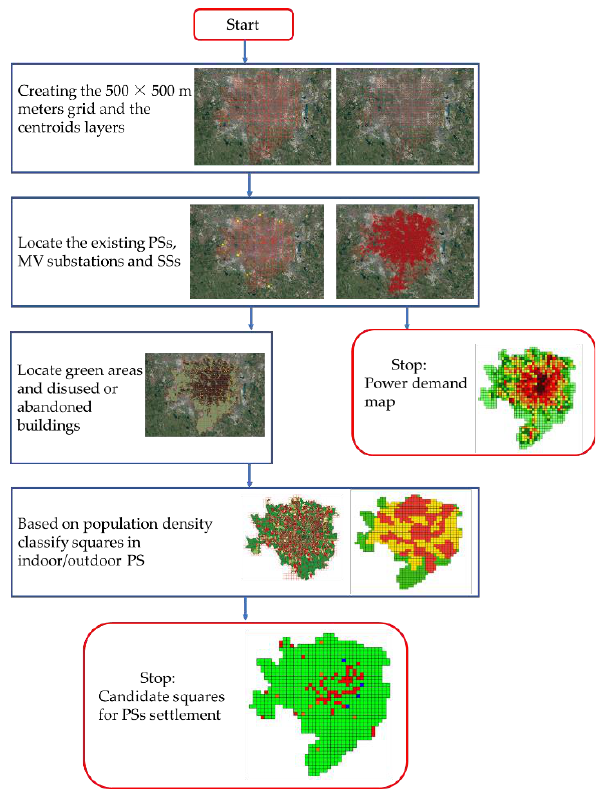
Figure 5. Flowchart of the input data preparation procedure.